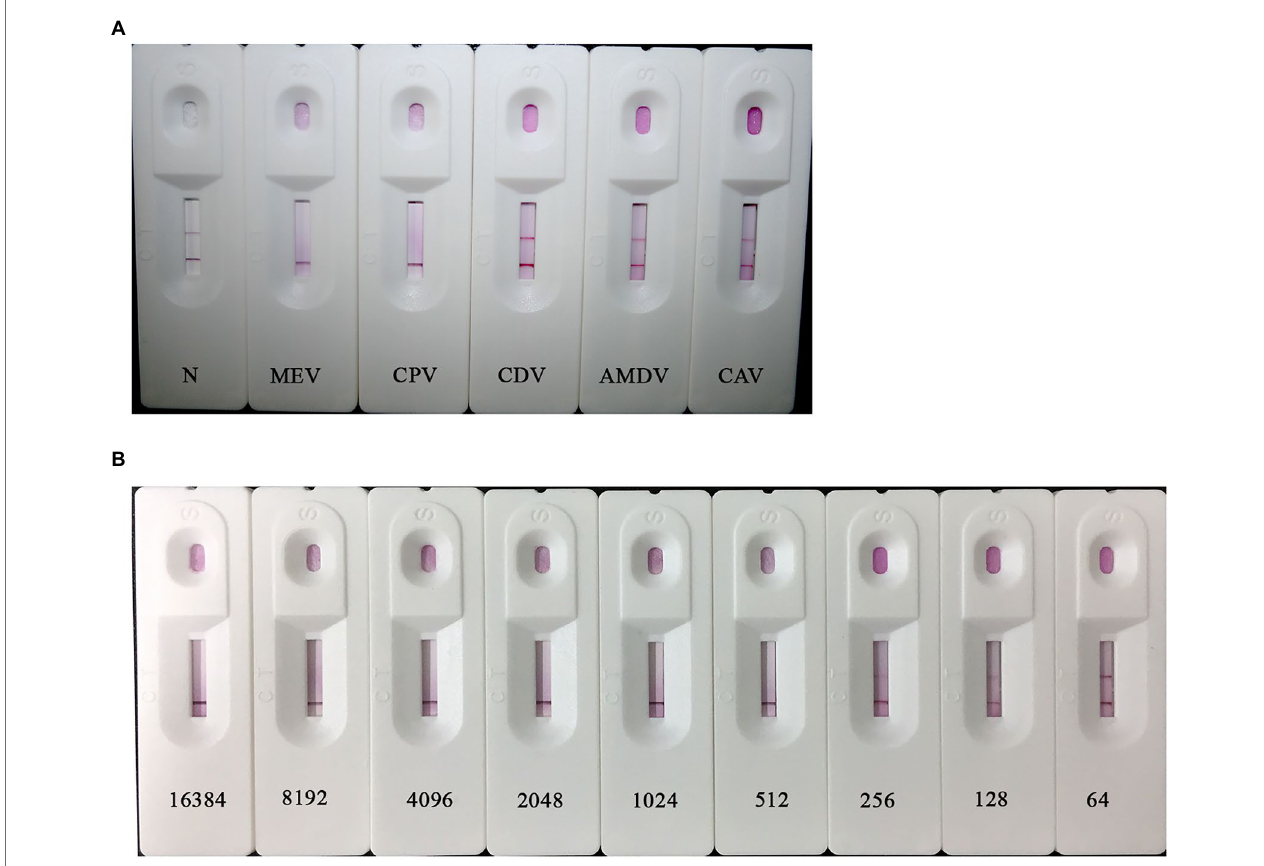
FIGURE 4 | Specificity and sensitivity of the colloidal gold ICS. (A) Specificity of the colloidal gold ICS. The MEV, CPV, canine distemper virus (CDV), Aleutian mink disease virus (AMDV), and canine adenovirus (CAV) strains were tested by ICS. All specimens other than MEV and CPV resulted in two bands on the T line and C line. (B) Sensitivity test of the ICS. Different concentrations of MEV B strain (MEVB) subjected to MEV ICS (2 14 –2 7 hemagglutination unit/100 μ l, respectively). Similar results were obtained in three independent experiments by different operators (data not shown).